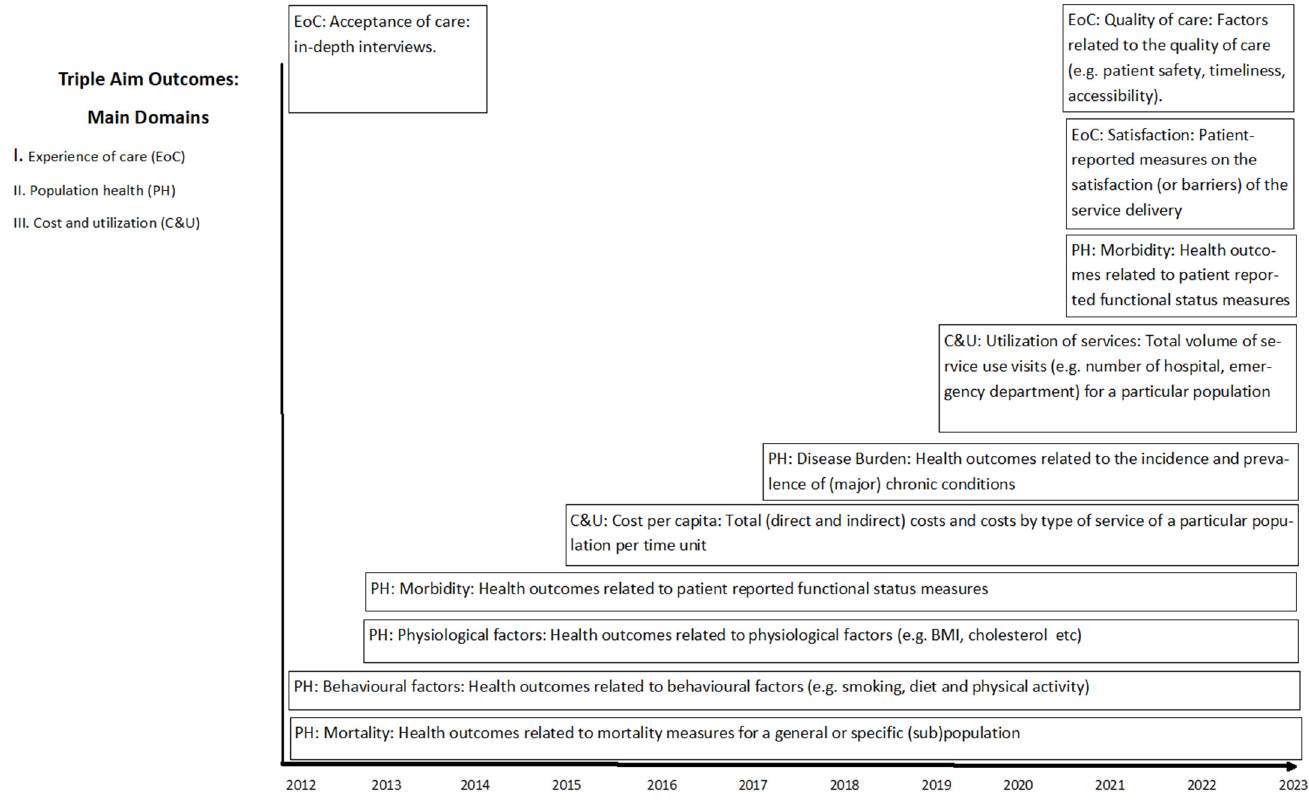
Figure 2 . Timeline showing the addition of new dimensions of effectiveness evaluation in ICM. Made by the authors.